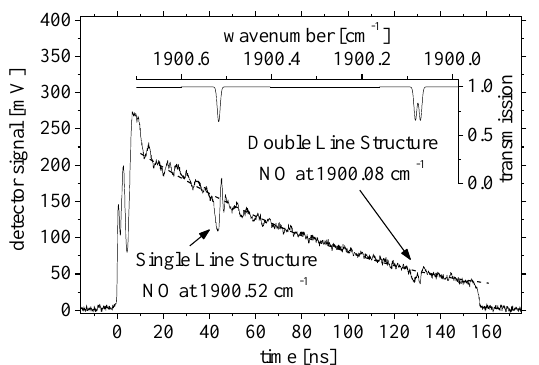
Figure 1. Principal sketch of the optical set-up used for temperature determination. The radiation of the QCLAS system was passed three times through the Pyrex discharge cell. The cell was 60 cm in length with an inner diameter of 20 mm. The experiments were performed under static gas conditions, P initial = 1.33 mbar [50], © IOP Publishing. Reproduced with permission. All rights reserved.